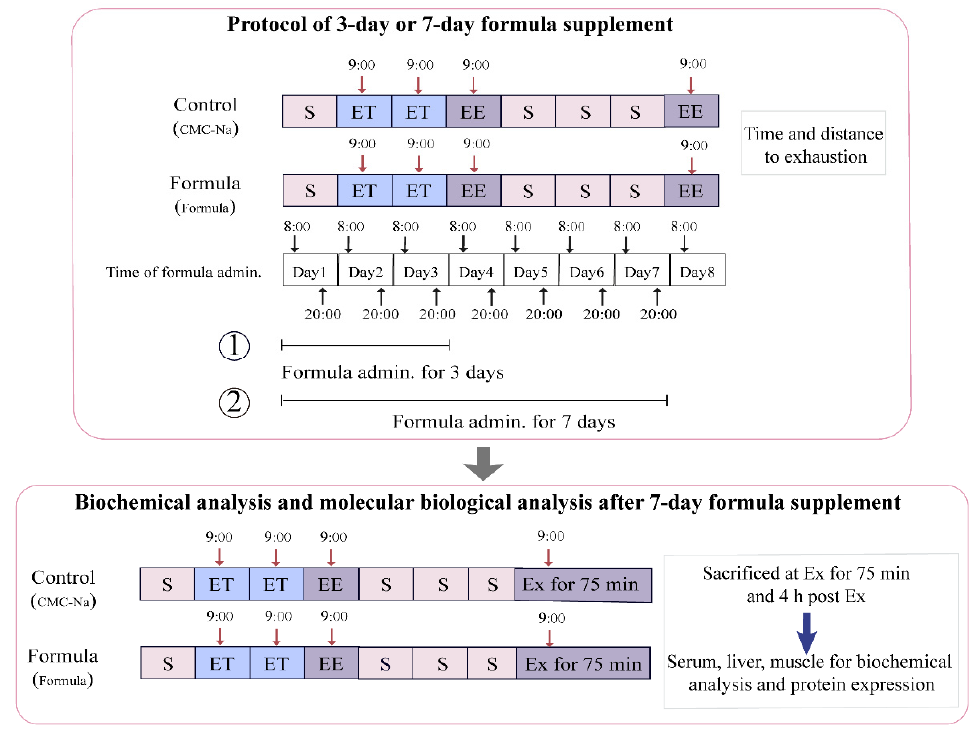
Figure 1. A schematic representation of the experimental design. Control: This refers to the control group, consisting of mice who were administered a 0.5% CMC-Na solution intragastrically and also received ET and EE. Formula: This refers to the formula group, consisting of mice who were administered an indicative dose of the formula intragastrically, as well as ET and EE. Ex: exercise. Ex for 75 min: This refers to exercise for 75 min according to the protocol of the exhaustive treadmill test. 4 h post-Ex: This refers to 4 h post-exercise for 75 min. S: sedentary; ET: exercise training; EE: exhaustive exercise. ① : The schedule of the 3-d formula supplementation, followed by EE. ② : The schedule of the 7-d formula sup- plementation, followed by EE.